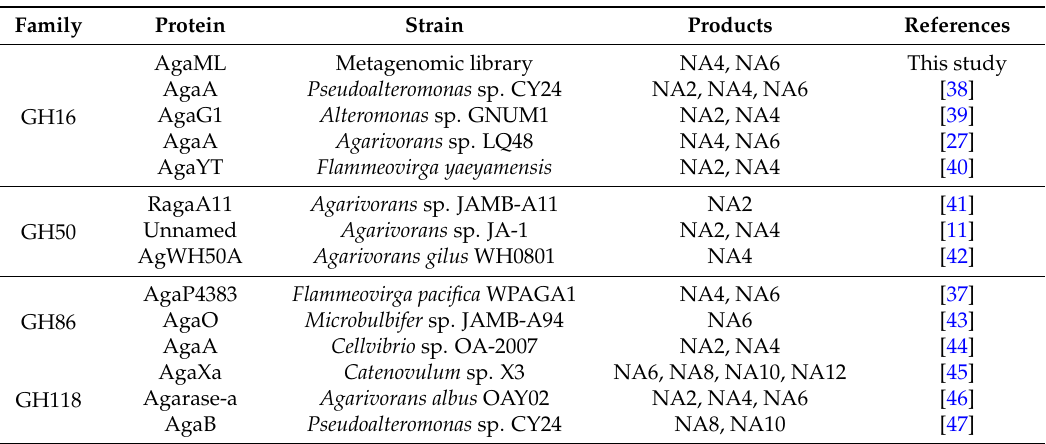
Figure 6. Thin layer chromatography (TLC) analysis of agar degradation by AgaML at different time points. Hydrolysis reactions were measured at pH 7.0 and 50 °C. Hydrolysates were taken at different incubation times and analyzed by TLC. Neoagarobiose (NA2), neoagarotetraose (NA4), neoagarohexaose (NA6), and neoagarooctaose (NA8) were used as standards. Table 2. Hydrolysis products of characterized agarases.